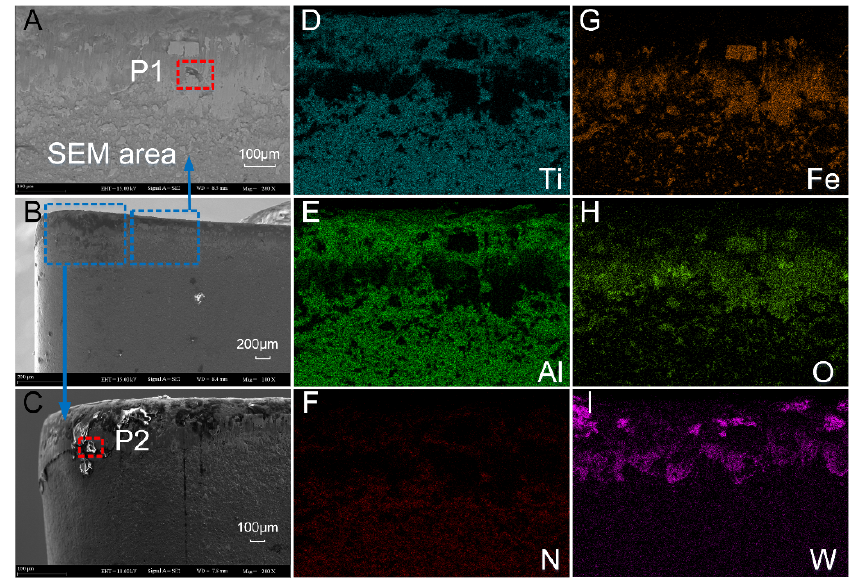
Figure 17. ( A – C ) The flank face wear of Tool B after 110 min of cutting. ( D – I ) Distribution of major elements.